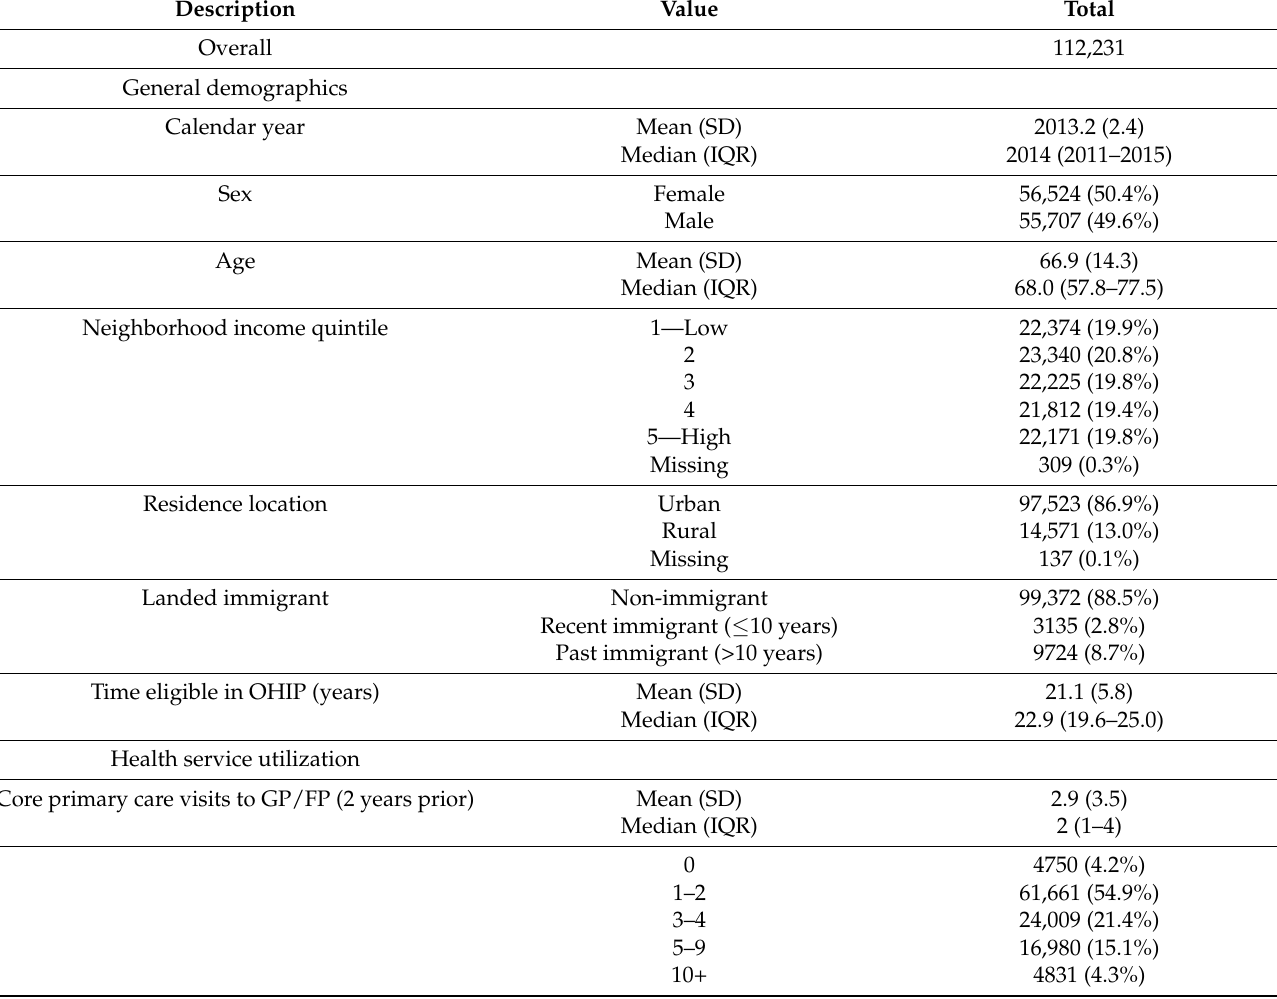
Table 1. Descriptive table of eligible subjects, measured at the cancer diagnosis